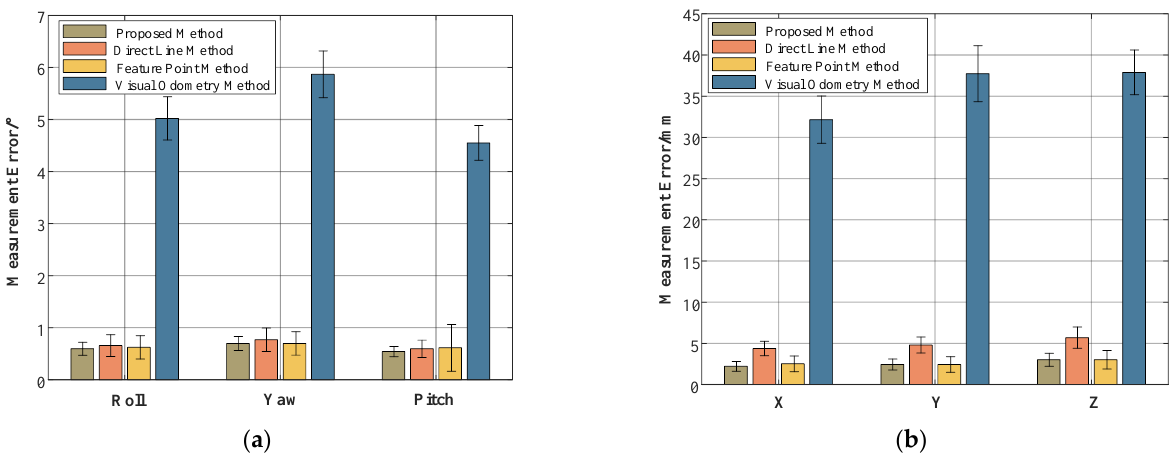
Figure 8. Statistics of the measurement accuracy of the different algorithms. ( a ) Attitude measurement error; ( b ) Position measurement error.